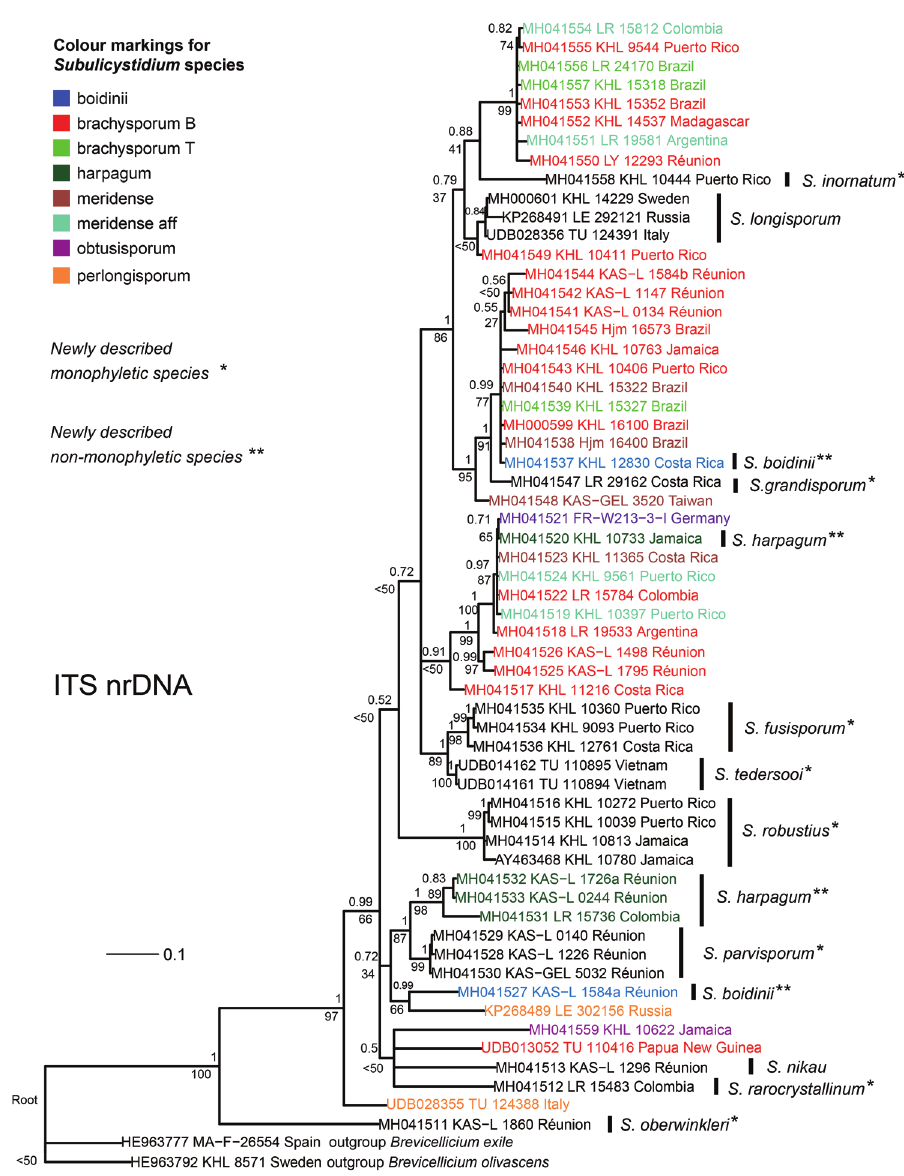
Figure 12. Phylogenetic relationship of Subulicystidium based on ITS nrDNA sequences. 50% major- ity-rule consensus tree from Bayesian analysis is shown, with posterior probabilities above the branches and bootstrap support values from the maximum likelihood estimation below the branches. Tips of the tree are annotated according to morphological identification and marked with colours in non-monophy- letic taxa (see legend). In the legend, the capital “B” following epithet in S. brachysporum means mor- phological species concept following Boidin and Gilles (1988), while “T” means the species as described by Talbot